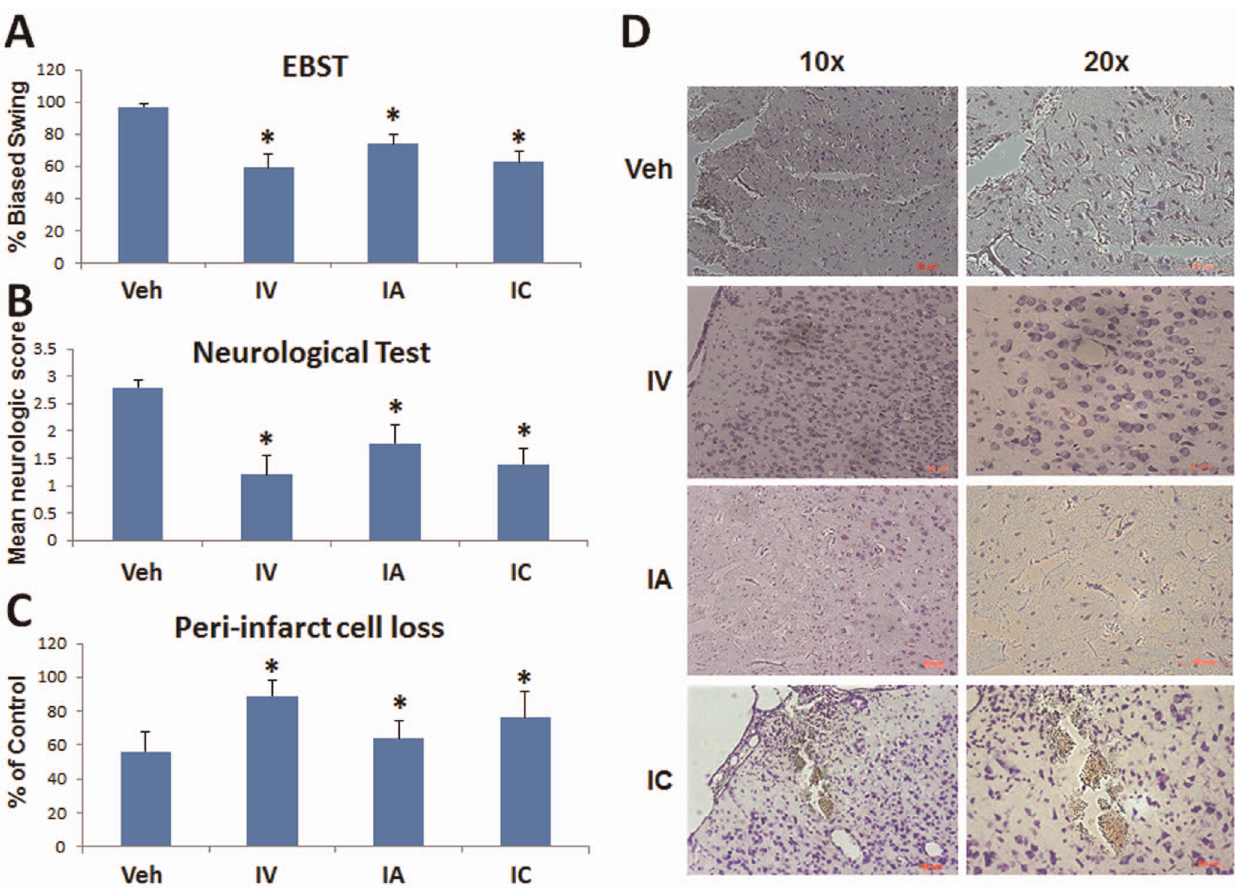
Figure 5. DPC grafts attenuate stroke behavioral and histological deficits. DPC transplanted stroke rats displayed significant improvement in their behavioral performance as revealed by decreased biased swing activity in EBST (A) and reduced impairment score in neurological test (B) compared to stroke rats that received vehicle only (*p , 0.05). The transplanted stroke rats that received either IV or IC transplants exhibited significantly better behavioral recovery than those that received either IA-delivered DPCs or vehicle infusion. Additionally, transplantation of DPCs in stroke animals significantly reduced the peri-infarct cells loss in the striatum (C, D), again with much more robust rescue of the peri-infarct area in IV and IC transplanted stroke rats compared to IA-delivered DPCs or vehicle infusion (*p , 0.05).